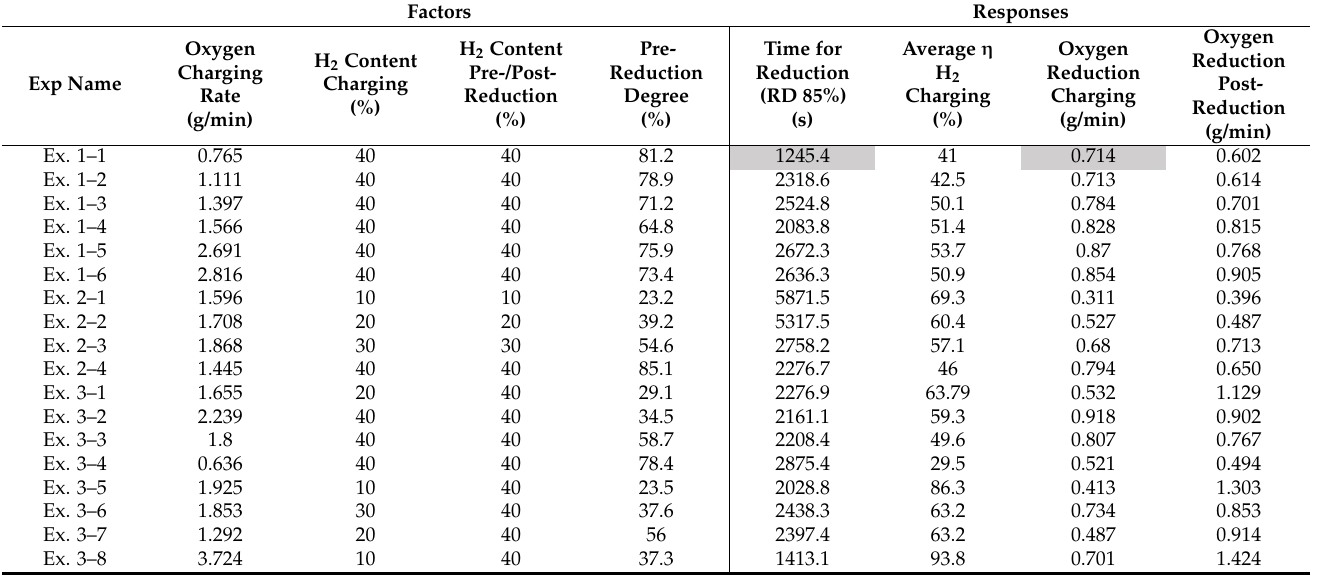
Table 7. Worksheet for the statistical analysis in MODDE ® 13